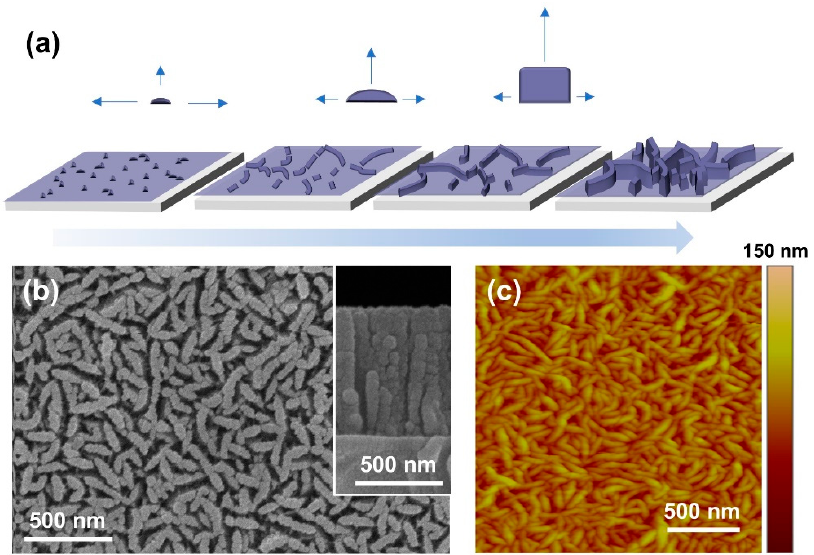
Figure 1. ( a ) Schematic illustration of the nanowall growth sequence. ( b ) Scanning electron microscopy (SEM) images and ( c ) atomic force microscopy (AFM) profile of the as-grown MoS 2 -MoS X nanowall surface after 3000 s of sputter deposition.